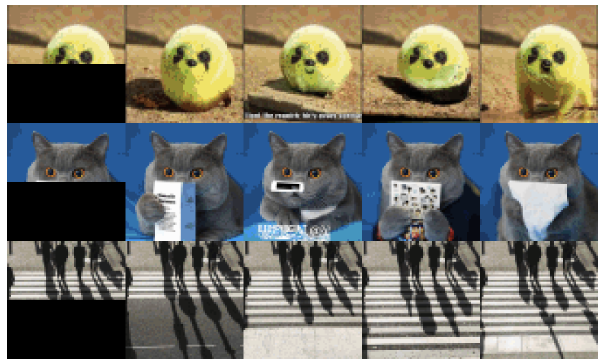
Figure 14. Example of Autoregressive Generation, Image GPT.